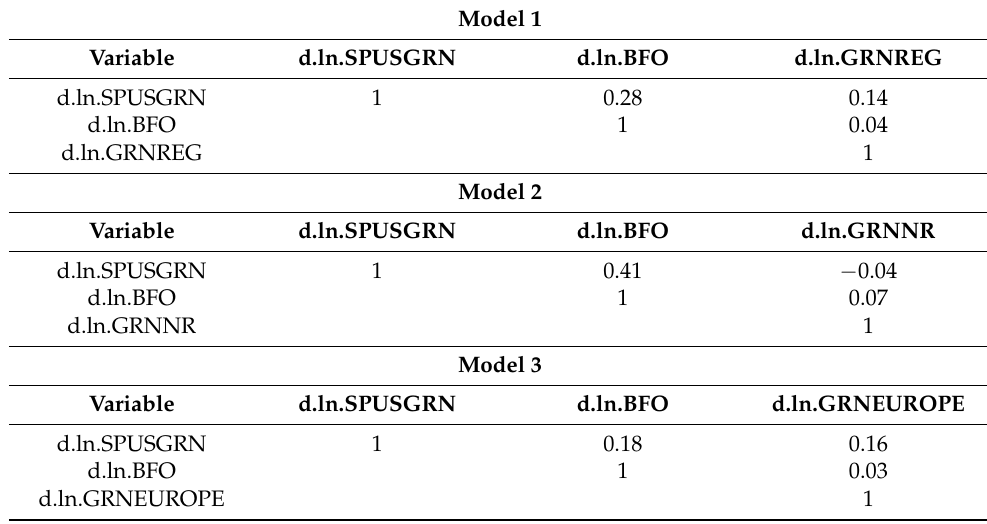
Table A1. Cross-equation correlation coefficients for residuals in models 1, 2 and 3.